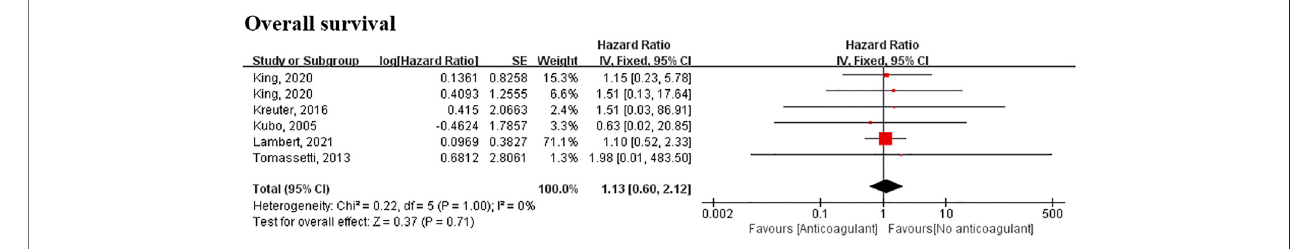
FIGURE 5 | Meta-analyses ofthe included studies examining overall survival for anticoagulant vs. no anticoagulant. The marker size indicates the relative weight of the study, as it contributes to the results of the overall comparison. IV indicates inverse-variance random-effects analysis; HR, hazard